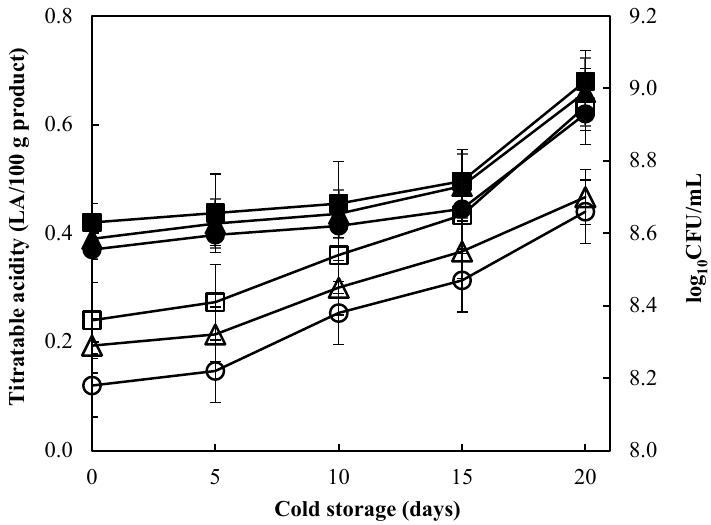
Figure 4. Microbiological population of lactobacilli ( △ :control experiment, □ : LAB-BS, ○ : MEL) correlated with titratable acidity ( ▲ : control experiment, ■ : LAB-BS, ● : MEL) during cold storage of sour milk produced with the strain L. pentosus FMCC E108 and full fat cow milk.